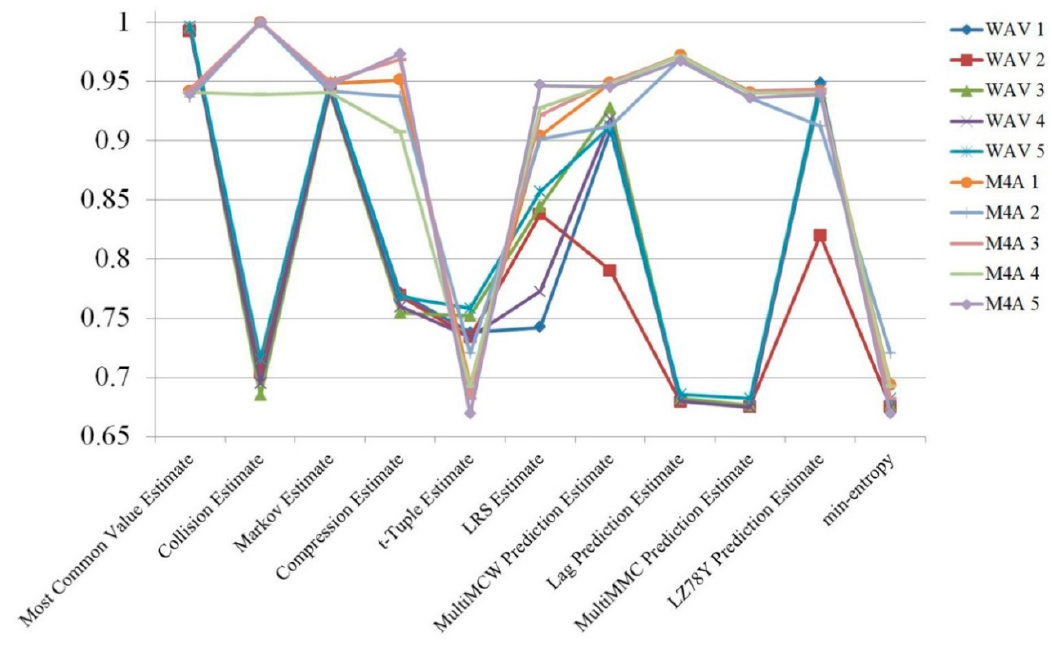
Figure 5. Randomness estimation results of radio signals collected with no delay.